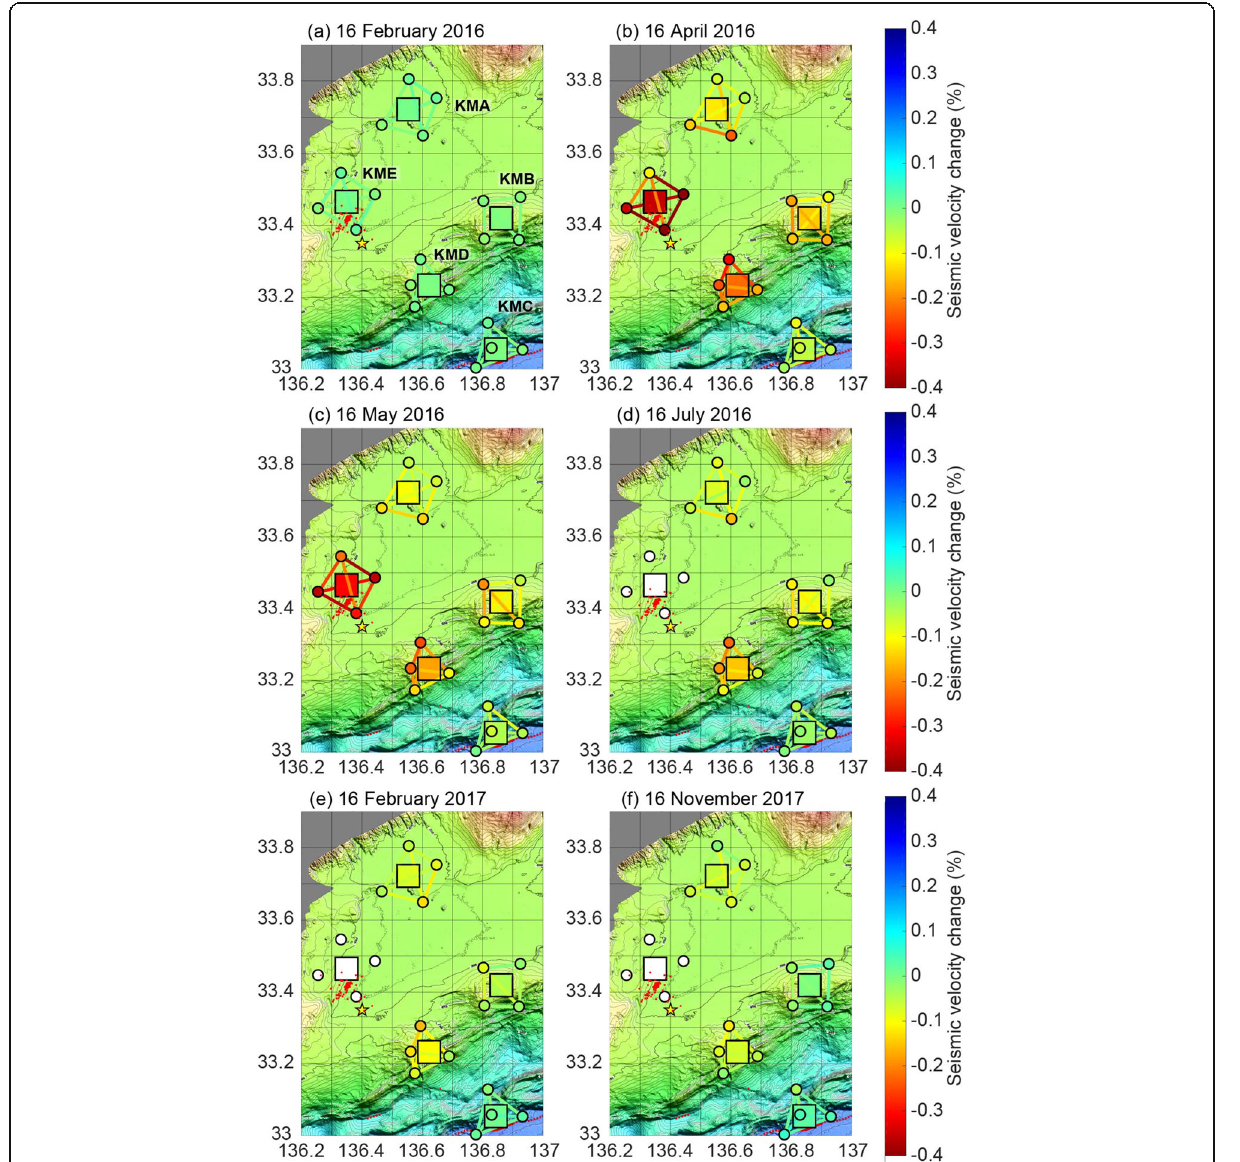
Fig. 6 Snapshots of spatial and temporal seismic velocity variations. Plots show 30-day windows centered on a 16 February 2016, b 16 April 2016 (including the day of the mainshock), c 16 May 2016, d 16 July 2016, e 16 February 2017, and f 16 November 2017. Squares represent the locations of nodes, and their colors represent averaged velocity changes at each node. Circles represent the locations of DONET stations, and their colors represent velocity changes at each station obtained by the tomography approach. Colored lines represent velocity changes between each station pair. The star marks the epicenter of the 2016 Off-Mie earthquake, and red dots are the epicenters of earthquakes in the period from 3 h before to 48 h after the mainshock (Wallace et al. 2016). Additional file 2 presents the complete time series as an